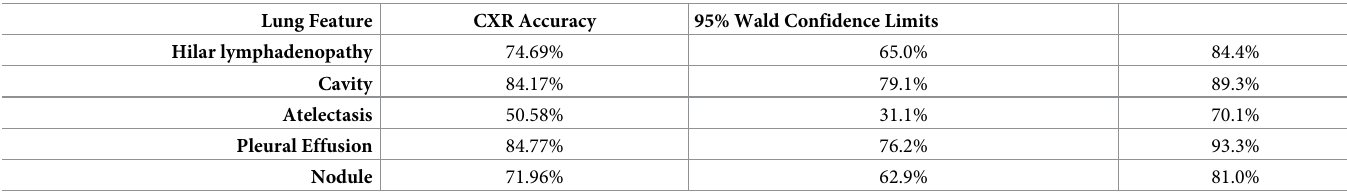
Table 8. 346 TBPP CXR Annotations versus Qure.ai Continuous Score, Receiver Operating Characteristic Statistics